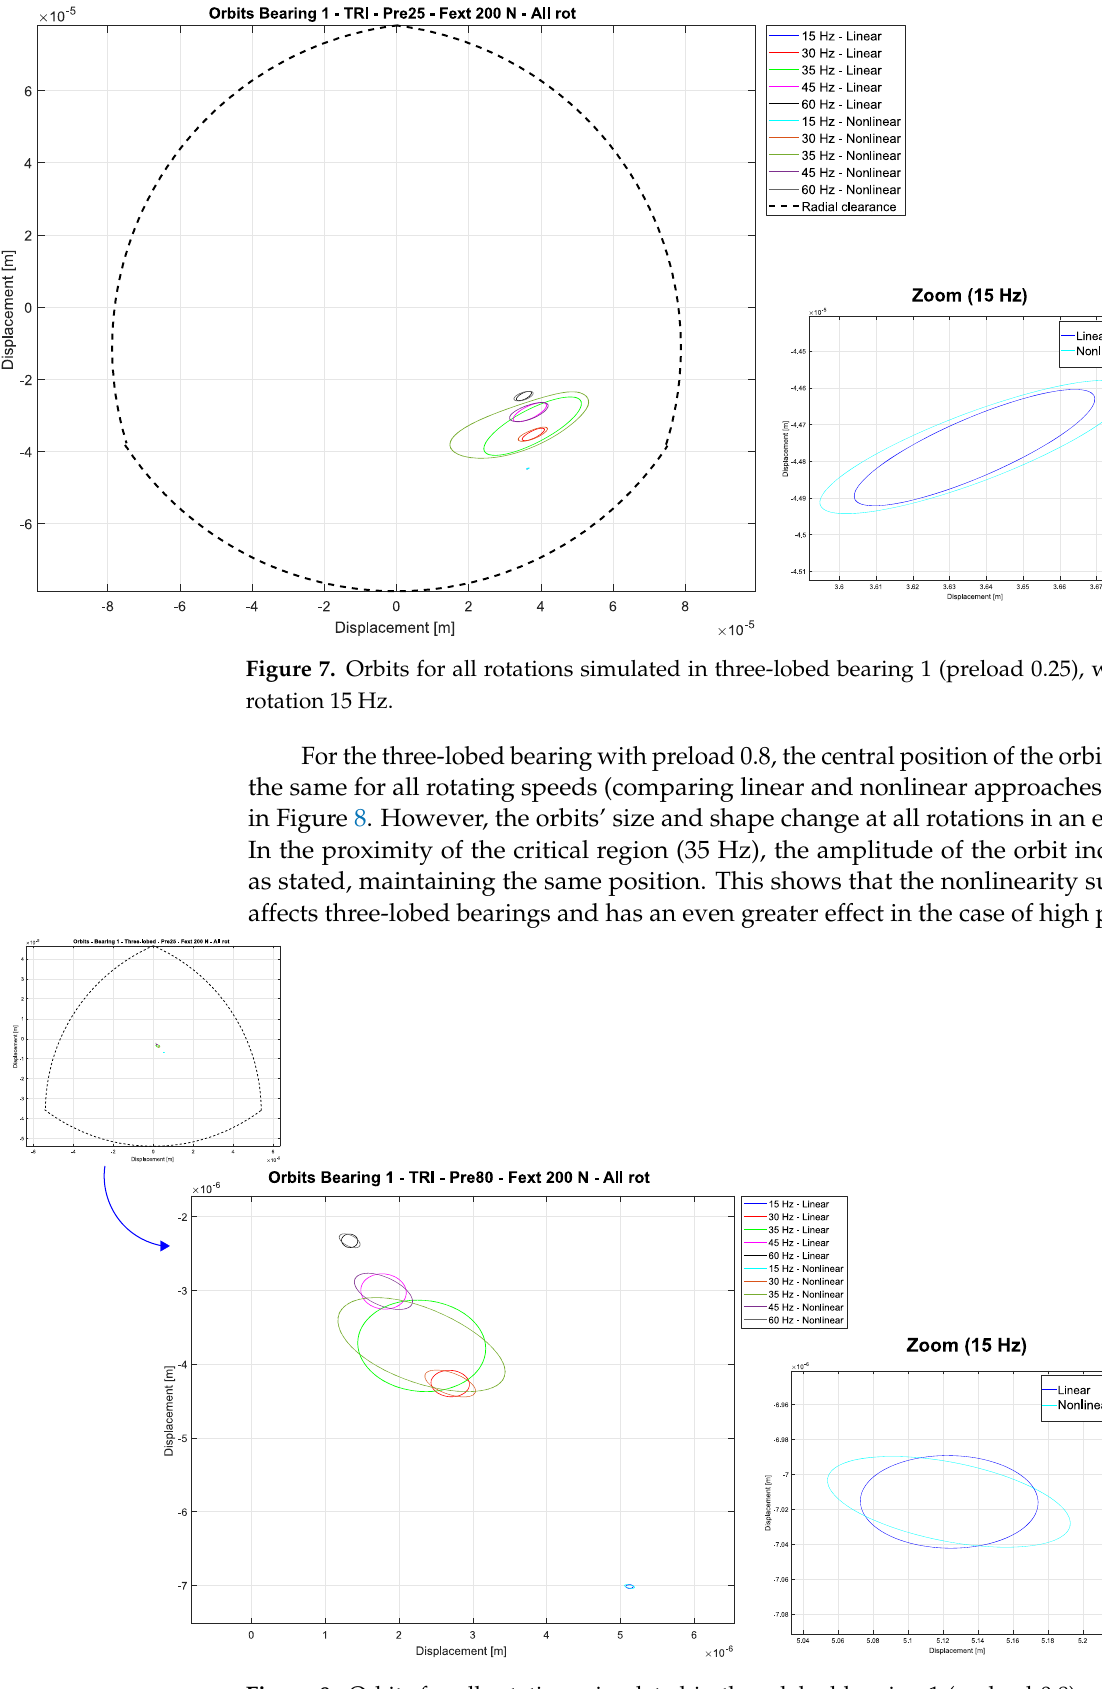
Figure 8. Orbits for all rotations simulated in three-lobed bearing 1 (preload 0.8), with zoom in rotation 15 Hz.